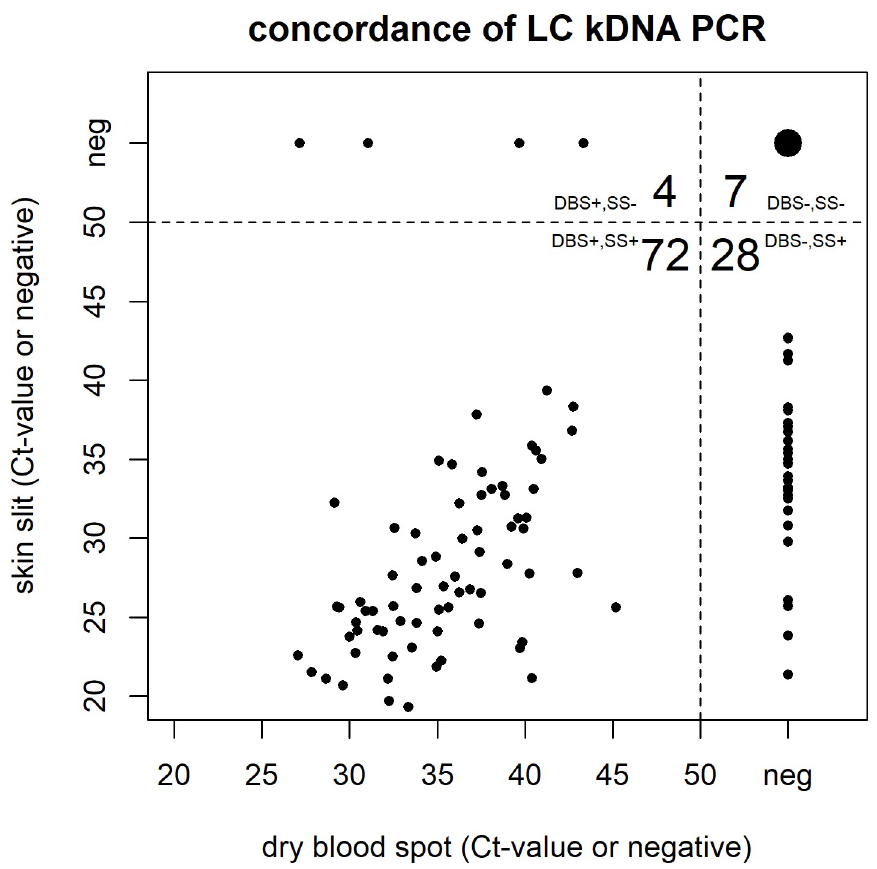
Fig 4. Comparison of Ct-values and concordance of Dry Blood Spots (DBS) versus Skin Scraping (SS) for the LC kDNA PCR.